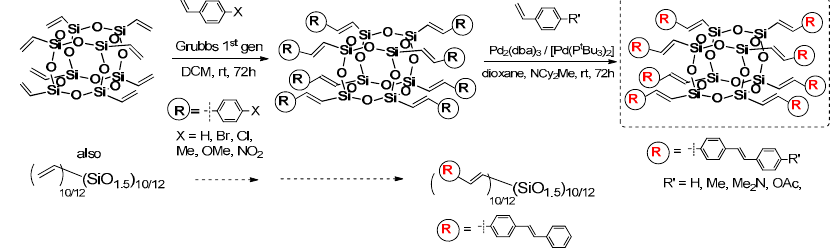
Figure 18. Reaction path for the selective sequence of cross-metathesis and Heck coupling towards (E)-styrenyl-substituted T 8 , T 10 and T 12 .